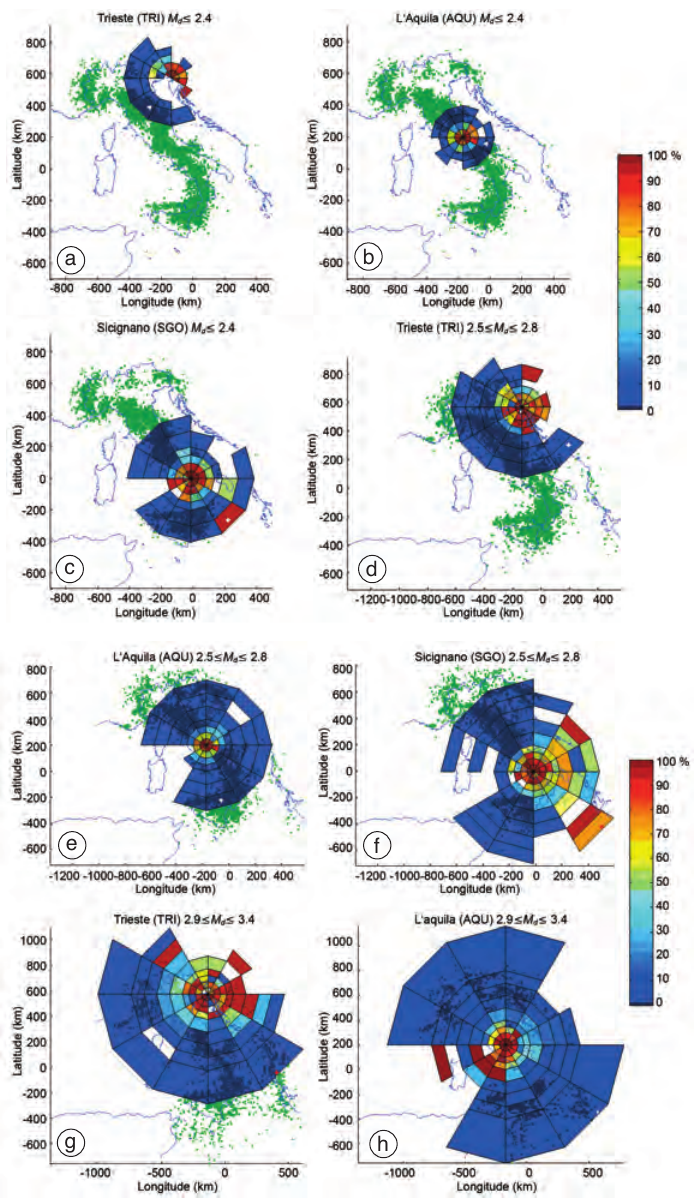
Fig. 15a-h. a) Percentage of events ( M d ≤ 2.4) detected by Trieste station. b) Percentage of events ( M d ≤ 2.4) detec- ted by L’Aquila station. c) Percentage of events ( M d ≤ 2.4) detected by Sicignano station. d) Percentage of events (2.5 ≤ M d ≤ 2.8) detected by Trieste station. e) Percentage of events (2.5 ≤ M d ≤ 2.8) detected by L’Aquila station. f) Percentage of events (2.5 ≤ M d ≤ 2.8) detected by Sicignano station. g) Percentage of events (2.9 ≤ M d ≤ 3.4) detected by Trieste station. h) Percentage of events (2.9 ≤ M d ≤ 3.4) detected by L’Aquila station. The criteria are explained in fig. 14. Green dots are the events recorded by the RSNC network in the range of duration magnitude